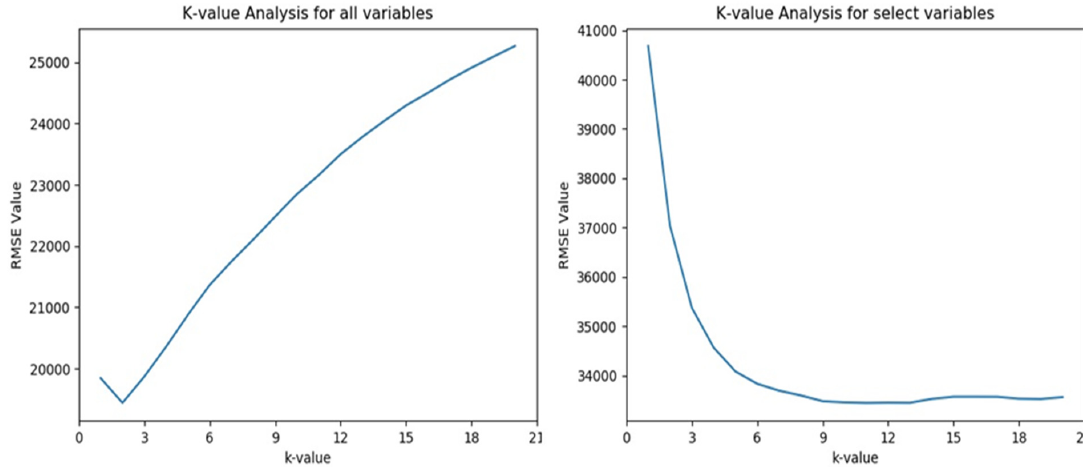
Figure 9. Identifying the ideal k-value for K-Nearest Neighbors.